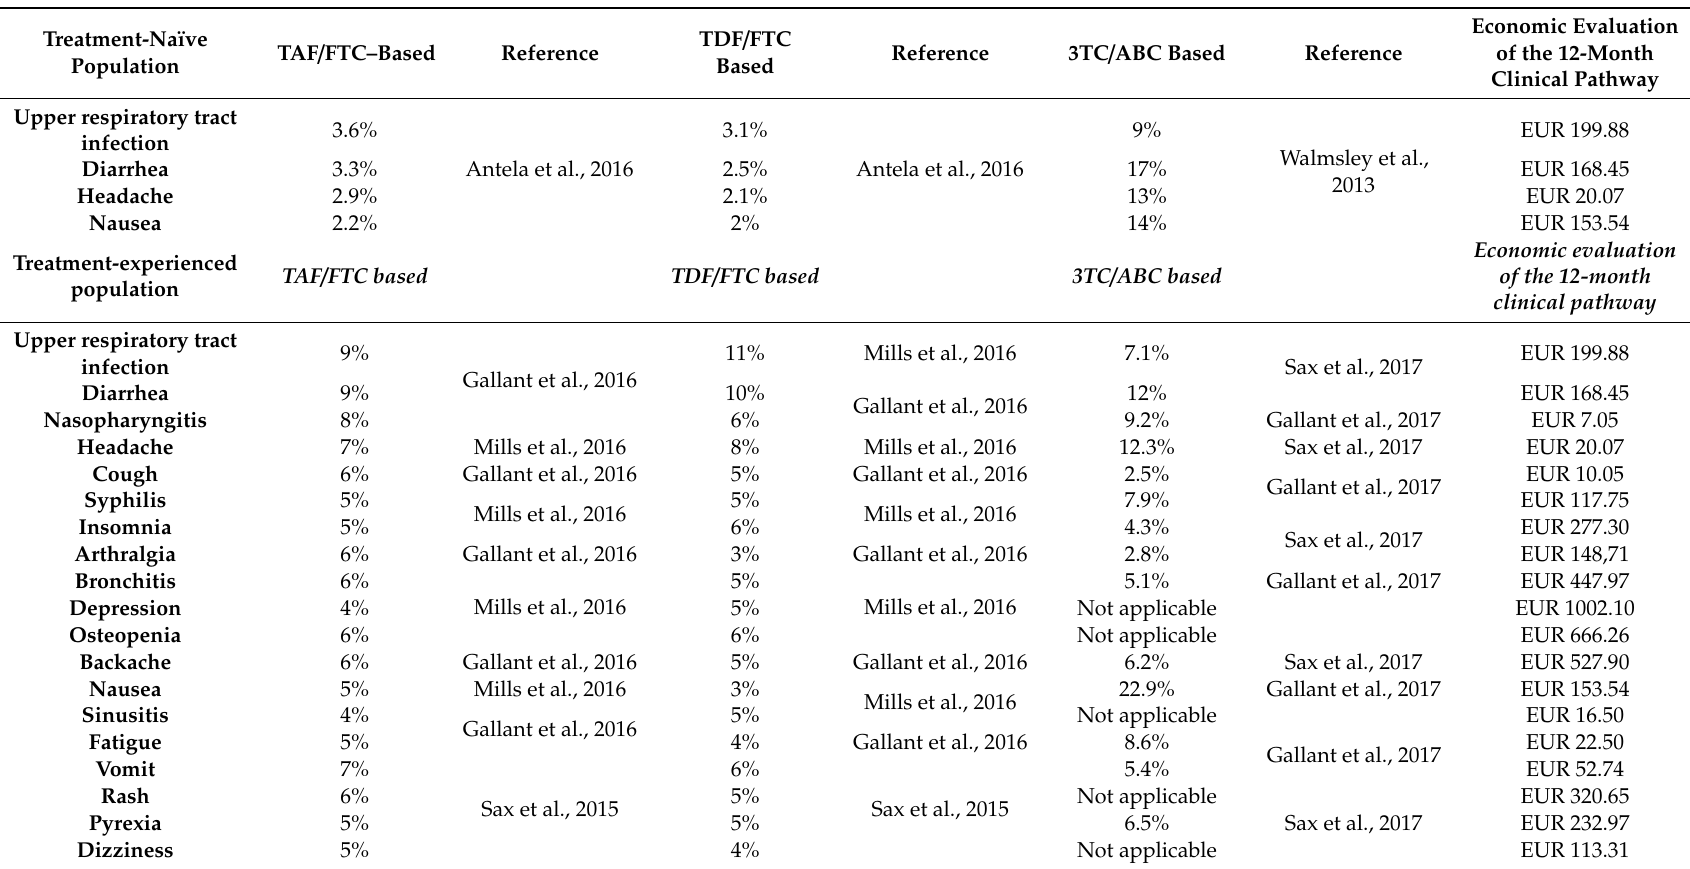
Table 4. Drug-related adverse event incidence rates of the three regimens and related economic evaluation, for 12-month clinical pathway.